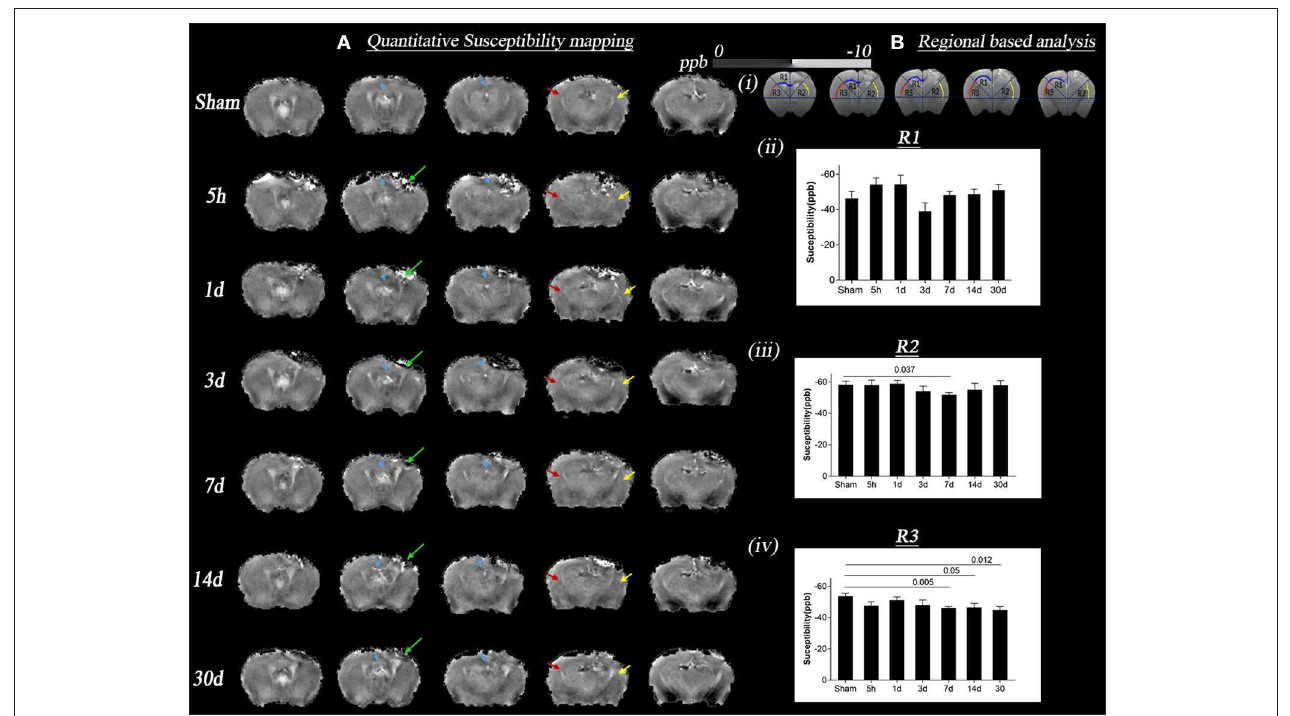
FIGURE 3 | Change in quantitative susceptibility in sham and TBI group at different time points (5h, 1 day, 3, 7, 14, and 30 days) post-injury. (A) Represents in vivo mean susceptibility maps of sham and TBI groups at different time points derived from quantitative susceptibility phase data. The green arrow marks the lesion areas, which are observed through contrast changes. Sections refer to the interaural regions at 3.5, 3, 2.5, 2, and 1.5mm. (B) (i) shows the regions of interest (ROI) R1, R2, R3, respectively, marked by yellow, red, and blue arrows on the susceptibility maps, the areas where changes in DTI voxel-based analysis were seen. T ipsilateral and contralateral corpus callosum and external capsule were picked as the areas of interest for ROI analysis; (B) (ii) represents the graph with p -values for susceptibility changes in R1, the maximum increase in susceptibility was on day 3 TBI vs. sham groups, however not significant; (B) (iii–iv) represents the graph with p -values for susceptibility changes in R2/ipsilateral, and R3/contralateral. The maximum increase in quantitative susceptibility in both the regions was observed on day 7 TBI vs. sham groups. A more significant change was noted in the R3 region. Values were expressed as mean ± SEM and non-parametric student t -tests were performed and corrected p -values were reported. Sections refer to the interaural regions 3.5, 3, 2.5, 2, and 1.5mm as per AMBMC mouse brain atlas (